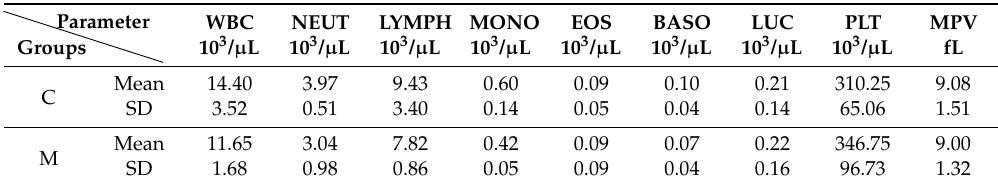
Table 3. Erythrogram of the peripheral blood of pigs from groups C and